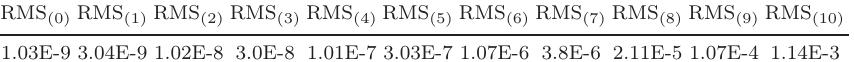
Table 7. Root-mean-square errors for example 4. RMS ( i ) denote the root-mean square error of y ( i ) ,i = 0 , 1 , 2 ,..., 10